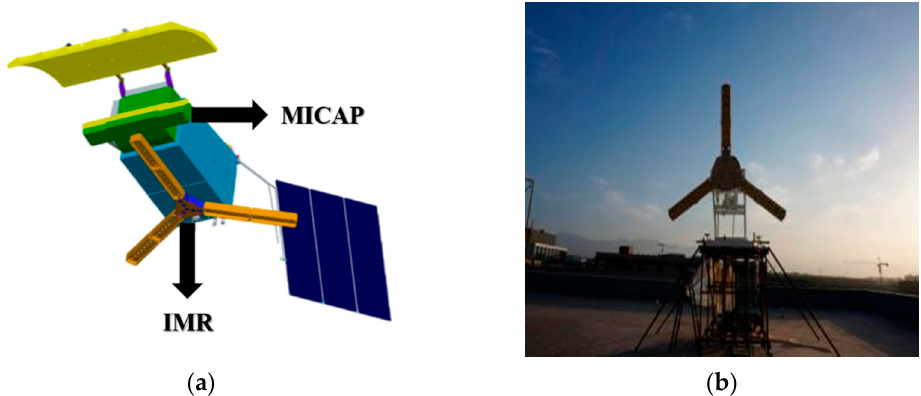
Figure 1. ( a ) Design of payloads Interferometric Microwave Radiometer (IMR) and Microwave Imager Combined Active and Passive (MICAP) onboard the Chinese Ocean Salinity Satellite, ( b ) prototype of the of IMR with the Y-shaped antenna array.